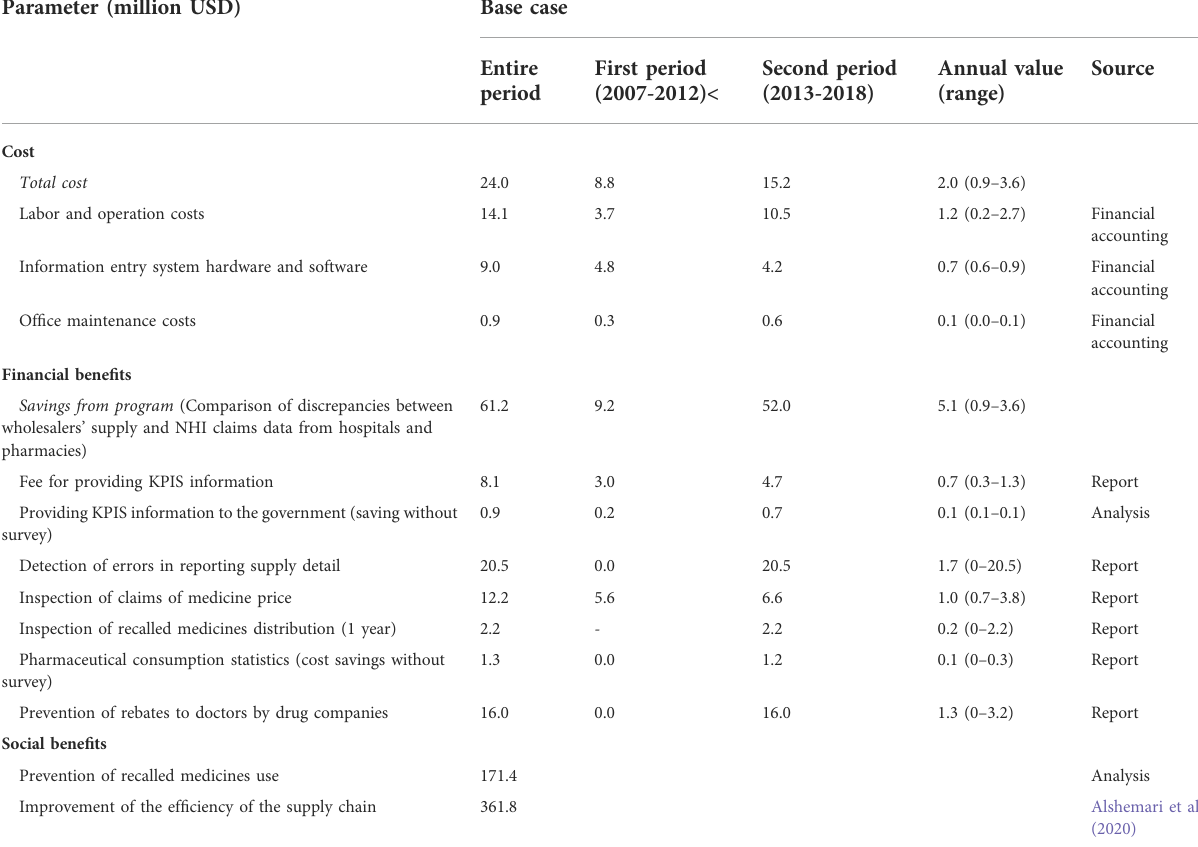
TABLE 1 Parameter values in the